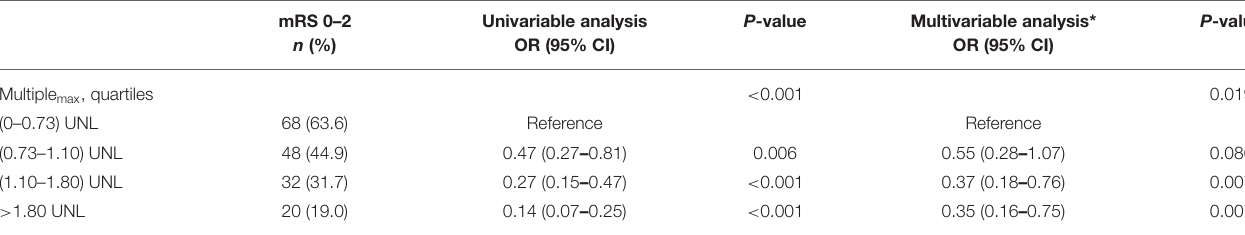
TABLE 4 | Multiple max for predicting favorable prognosis (modified Rankin Scale 0–2).